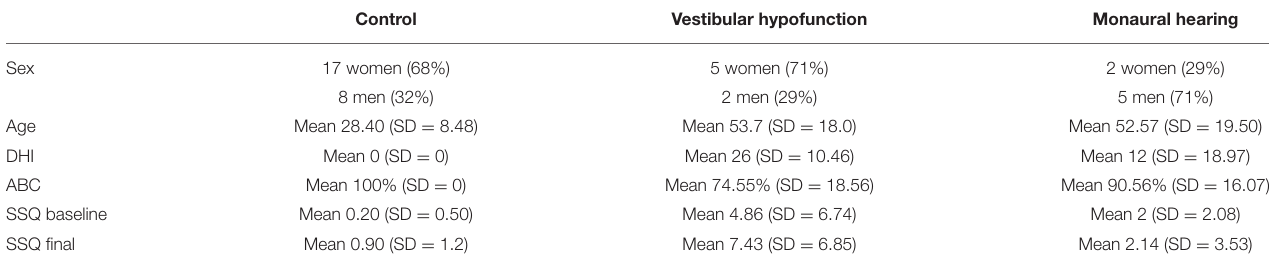
TABLE 2 | Sample demographics.